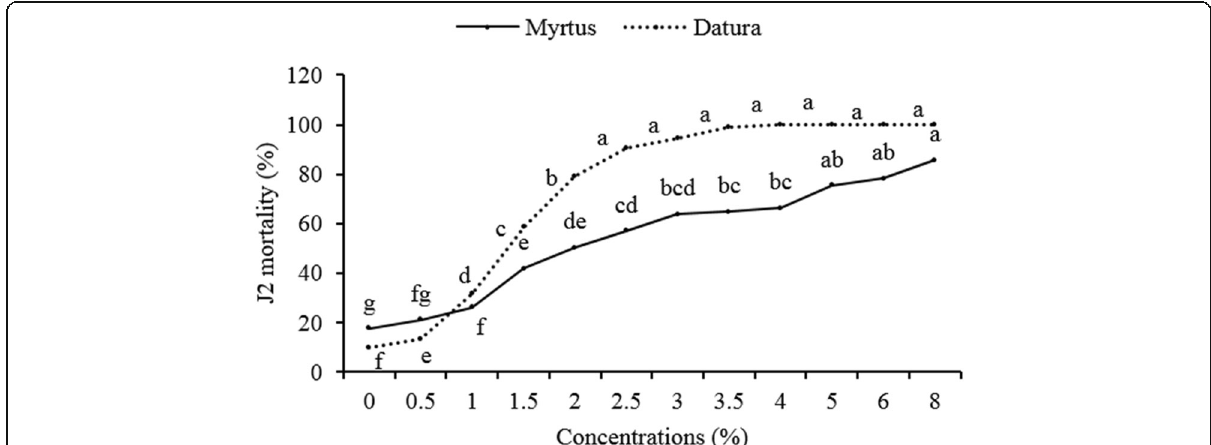
Fig. 3 Mean mortality (%) of Meloidogyne javanica juveniles exposed to different concentrations of Datura stramonium and Myrtus communis extracts. Means are average of four replications. Means followed by the same letter(s) are not different according to LSDs ( p ≤ 0.01)